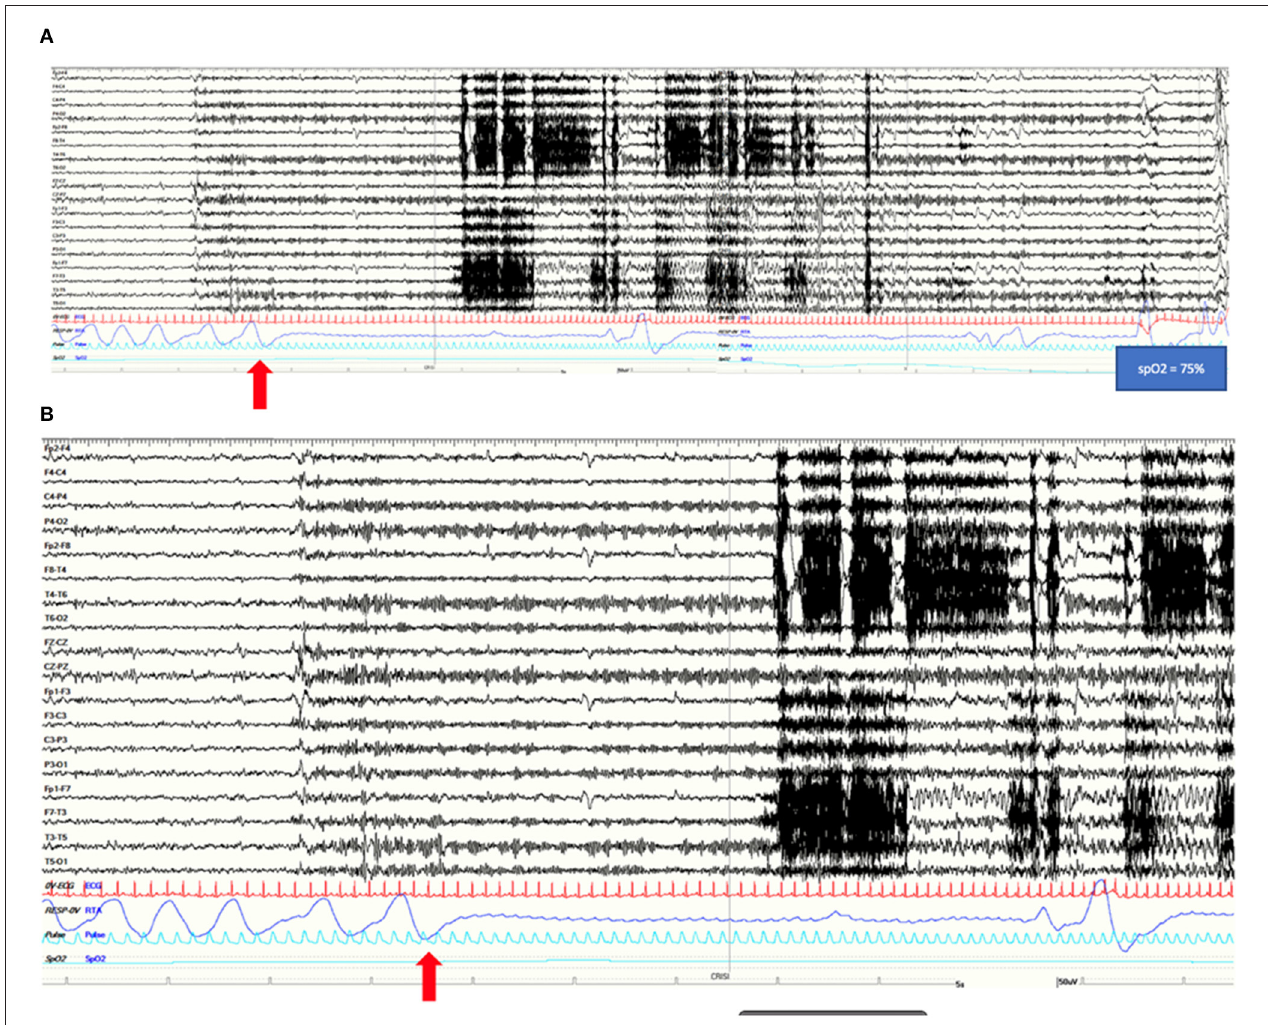
FIGURE 1 | (A) A 2-min view of the EEG pattern with polygraphy of a left temporal lobe seizure characterized by rhythmic theta and delta activity on left fronto-temporal regions in patient 1. This long-lasting apnea induces a severe oxygen desaturation (SpO2 75%). (B) A more detailed view of the onset of apnea preceding EEG changes and EMG movement-related artifacts by 20s. (A,B) Red arrows highlight the onset of the apnea. Note the ictal marked increase in heart rate. Red channel: ECG; blue channel: thoracoabdominal